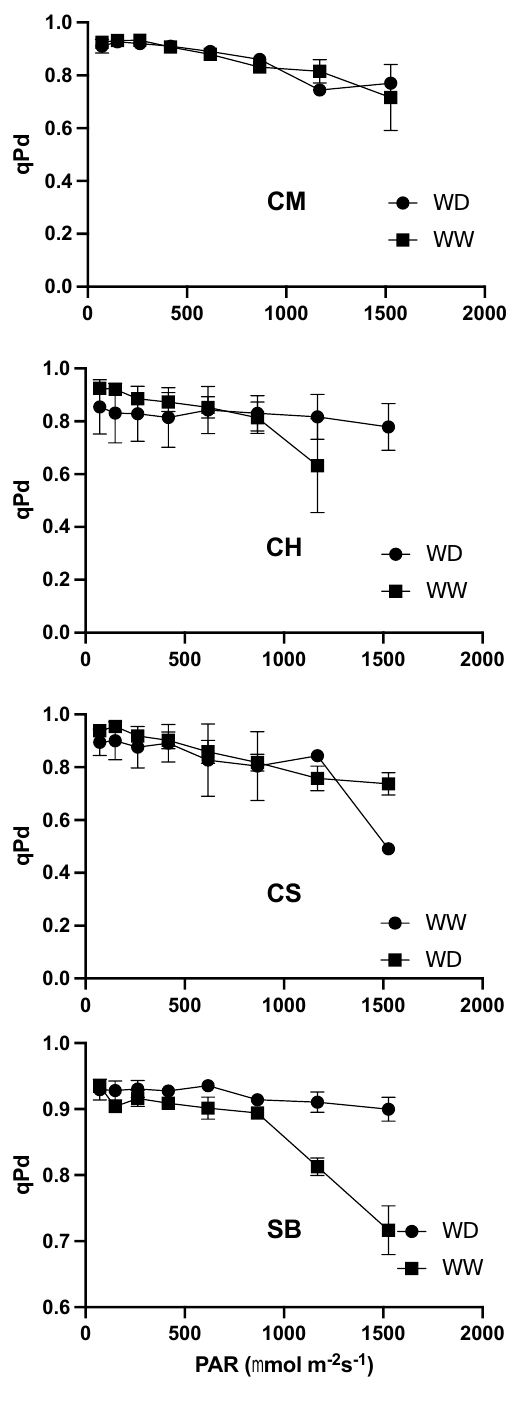
Figure 9. Photochemical quenching in darkness (qPd) upon increasing light intensities for WW (squares) and WD (circles) in Carmenere (CM), Chardonnay (CH), Cabernet sauvignon (CS) and Sauvignon blanc (SB). Error bars represents SE.